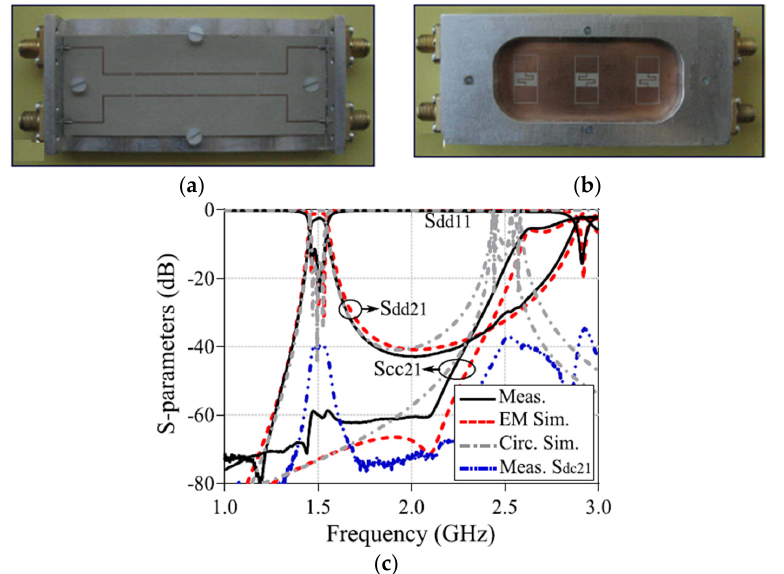
Figure 1. The proposed differential planar filter [42]: ( a ) Front view of the prototype; ( b ) Back view of the prototype; ( c ) Simulations and measurement results.